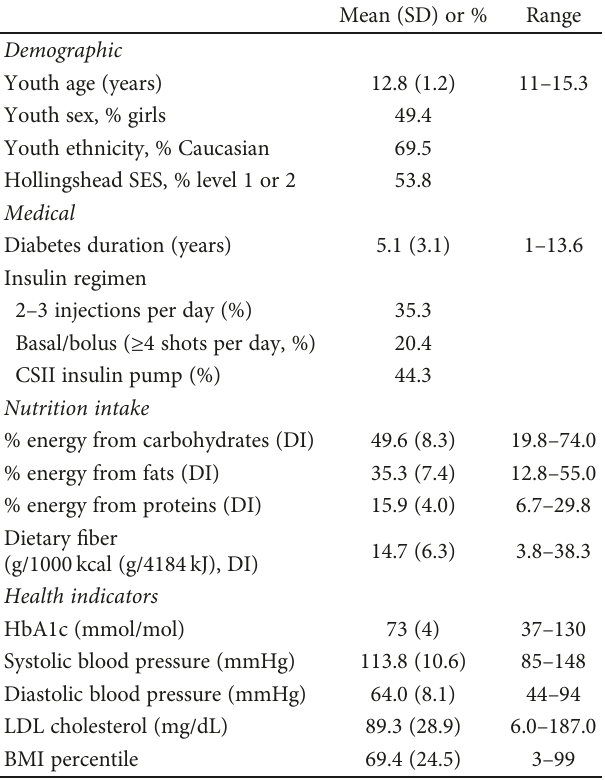
Table 1: Demographic and baseline